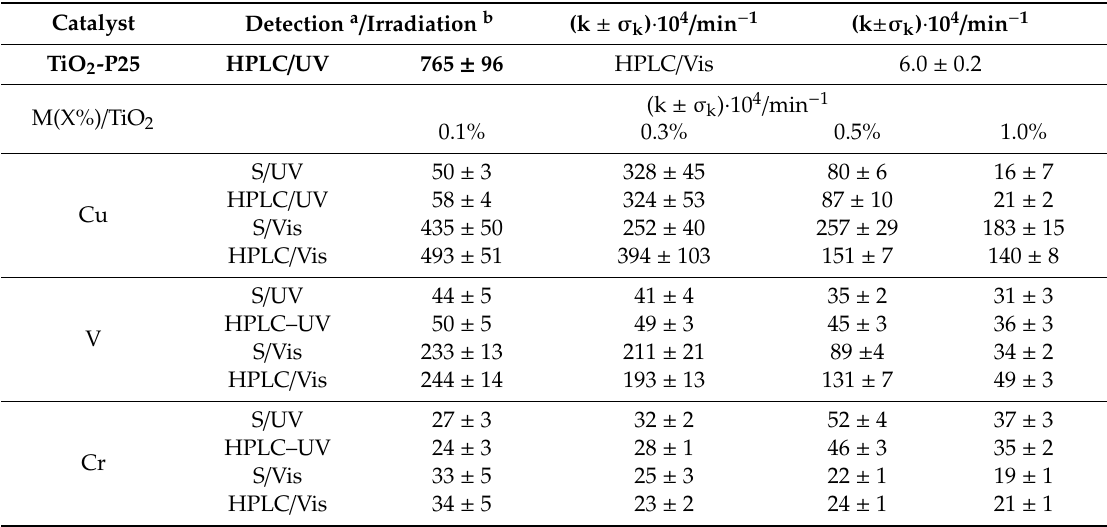
Table 4. Apparent degradation rate constants obtained in the photocatalyzed degradation of phenol over M(%X) / TiO 2 composites under Vis ( λ exc > 366 nm) and UV ( λ exc = 255 nm)